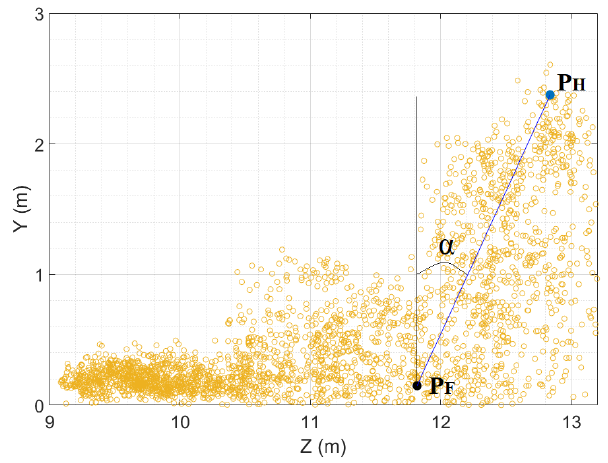
Figure 16. Length and inclination angle ( α ) of the fire presented in Figure 3.